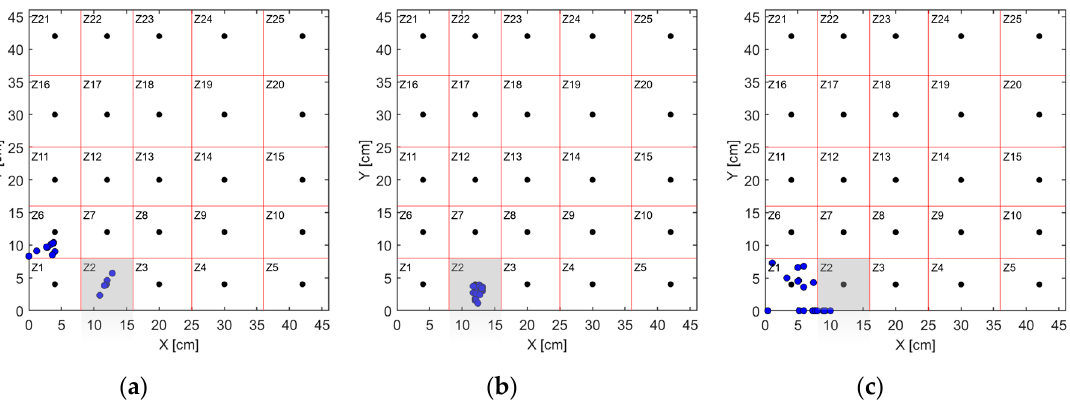
Figure 7. Localized sources estimated using the single-stage AIC method when the hit sources were on a border of the sensor network (or corner region): when a hit was applied ( a ) on the raft top, ( b ) under the raft bottom, and ( c ) at the middle of Pile #2. In ( c ), the middle of the pile at a distance 10 cm down from the top of the raft was struck.